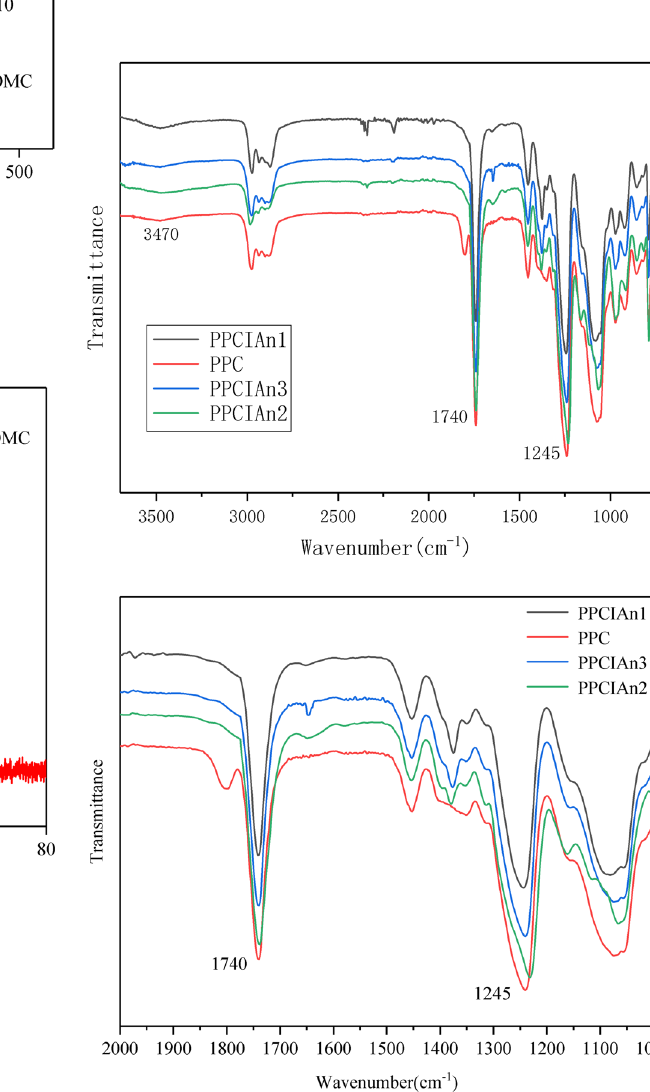
Figure A3: FT - IR spectra of copolymers PPC and PPCIAns.